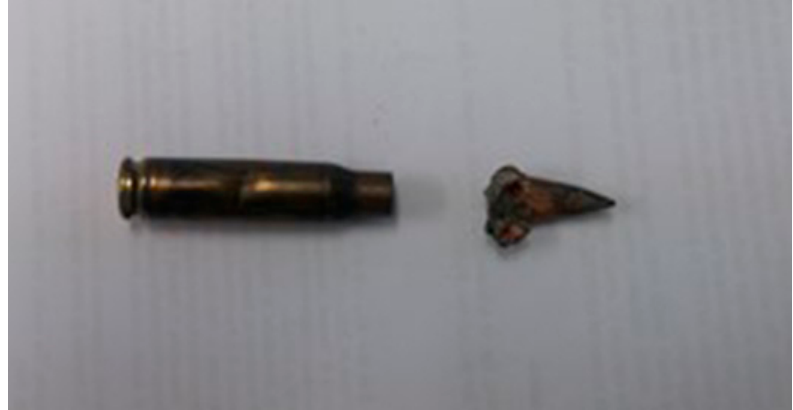
Figure 4. Bullet after impact.